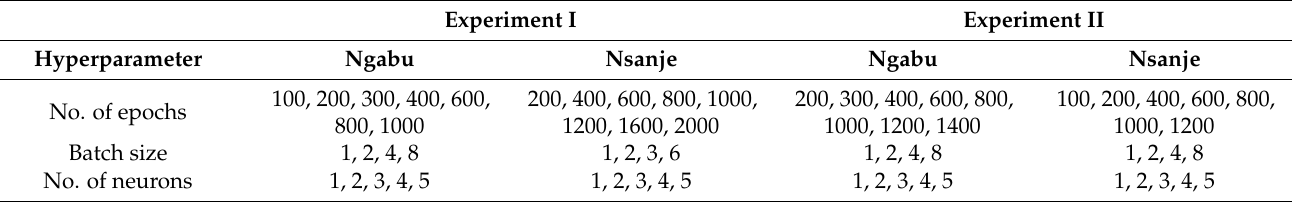
Table 4. Description of the hyperparameter setting combinations tested in the LSTM model.